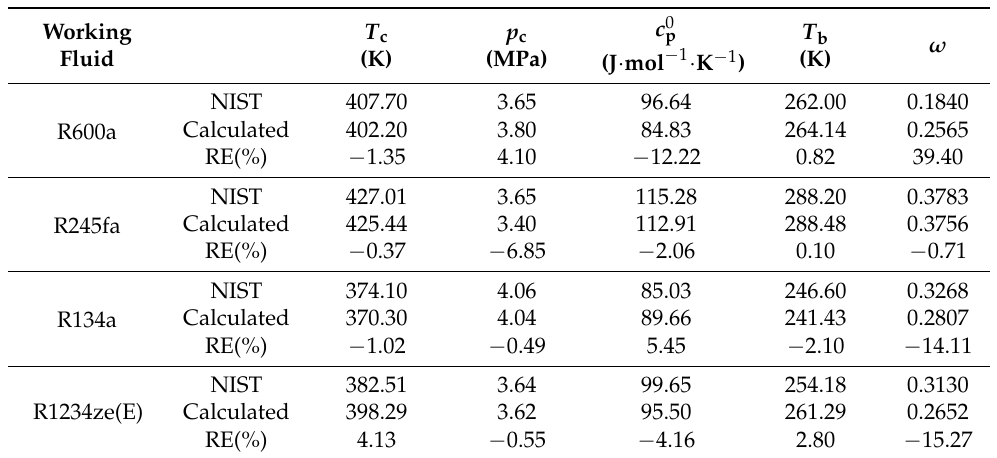
Table 4. RE of four working fluid properties.